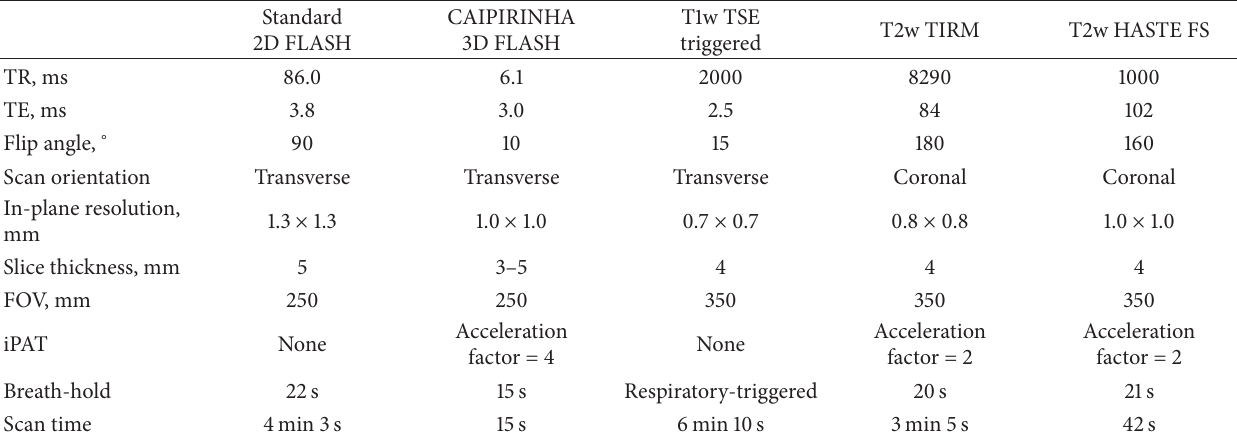
Table 1: Typical MRI scan parameters, as used in this